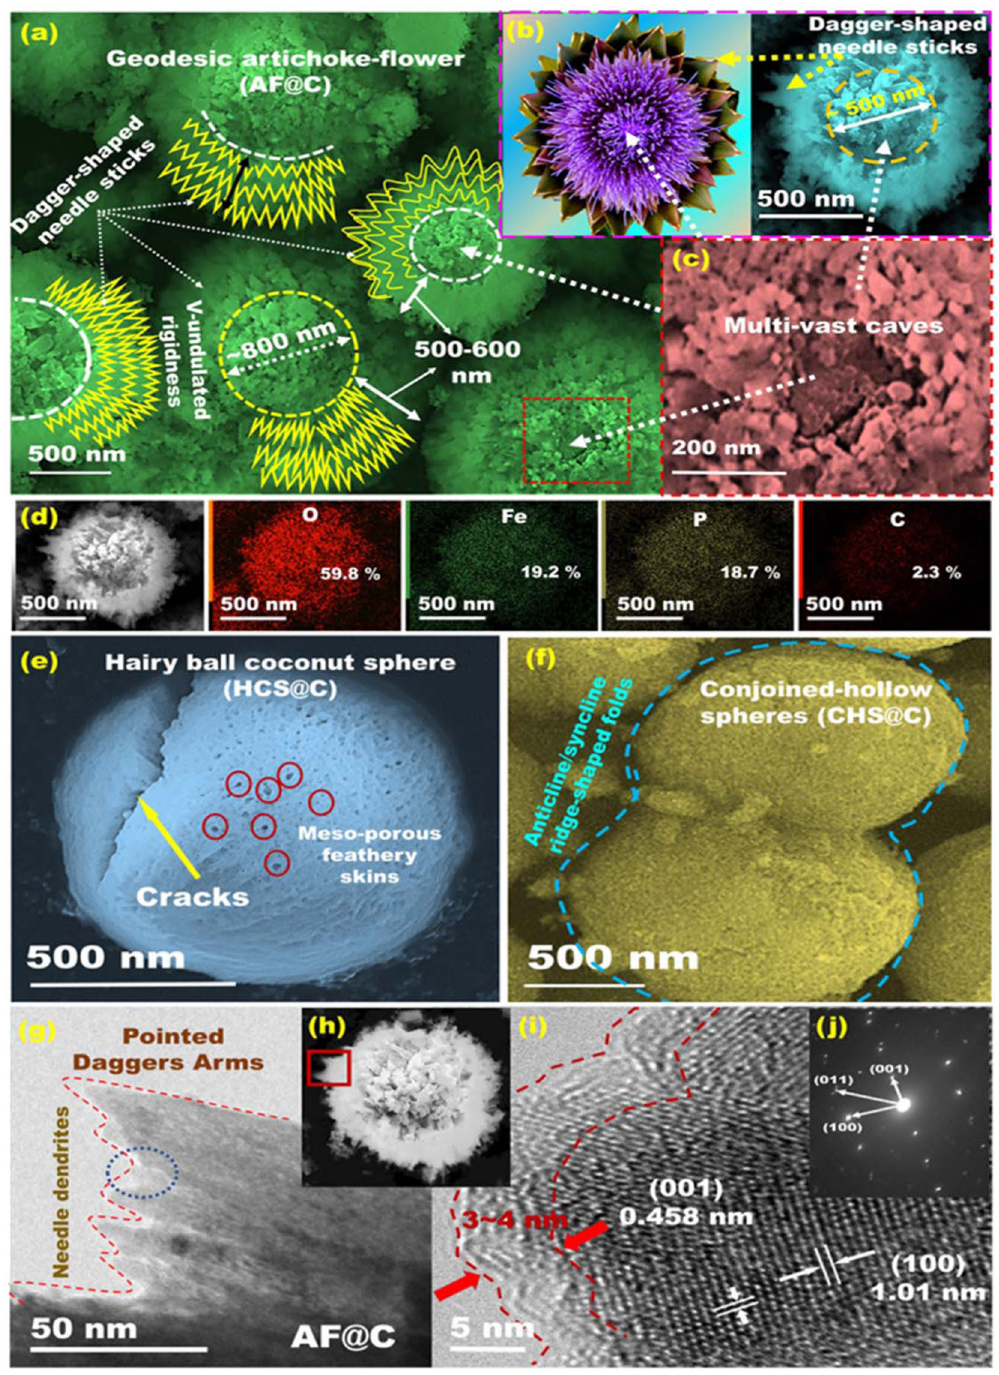
Figure 2. ( a – j ) FE-SEM, EDX–elemental mapping analysis, HR-TEM, and electron diffraction profiles of the exposed heterogeneous hierarchy open-geode AF@C model, HCS@C, and CHS@C cathode composites. ( a , b ) Low- and ( d ) high-magnification FE-SEM of LFPO@C with geodesic AF@C (cathode) with serrated cuticle walls and channel-like needles running along the exterior feathery tube pipes. ( d ) EDX and elemental mapping analysis (mass ratios) of AF@C geode of O (59.8%), Fe (19.2%), P (18.7%), and C (2.3%). ( e ), and ( f ) represented the FE-SEM of HCS@C, and CHS@C, respectively. ( g ) High- and ( h ) low-magnification HR-TEM micrographs at the edge of hand-like pointed daggers on the surface of AF@C microparticle. ( i ) High-magnification HR- TEM of polyhedron lattice pattern at the edge with a clear thin layer (3–4 nm) of C coating on the surface of AF crystals. ( j ) SAED pattern image of AF@C meso-geodesics along the [010] crystallographic direction indicating the formation of a single orthorhombic olivine mesocrystals with the AF@C